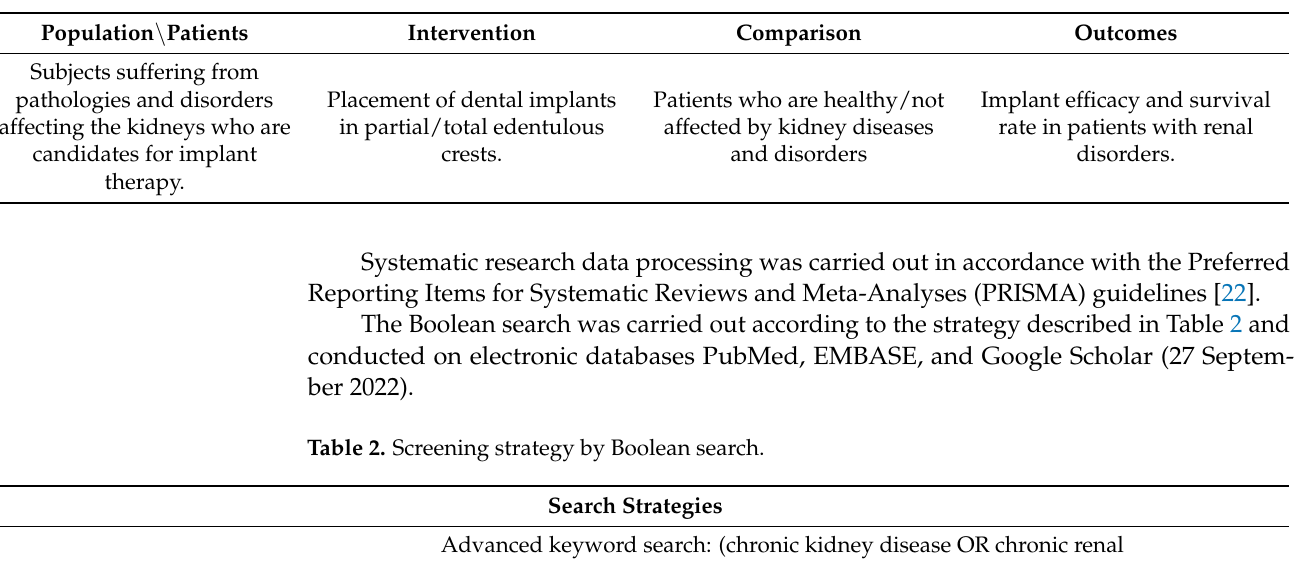
Table 1. Summary of the PICO (population, intervention, comparison, outcome) model.